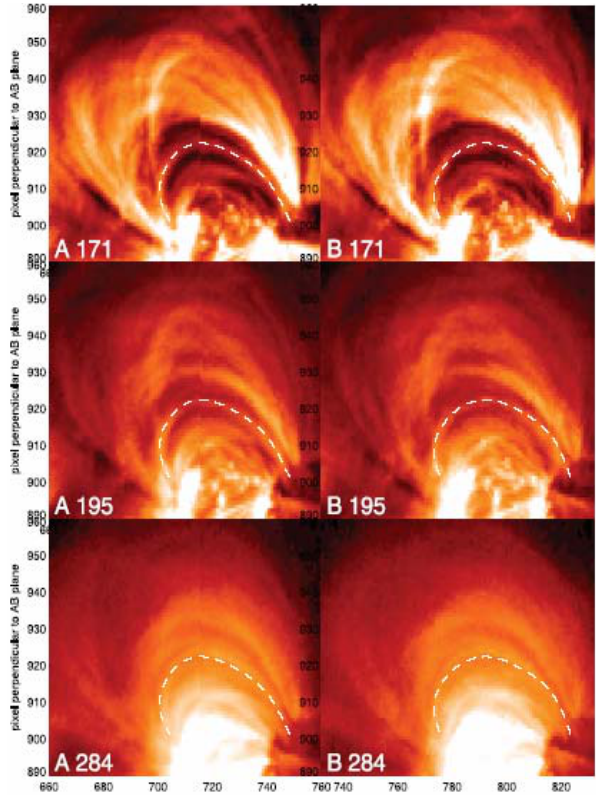
each other for the EUVI-images taken from both STEREO- viewpoints, which have been separated by 7 ◦ for this study.